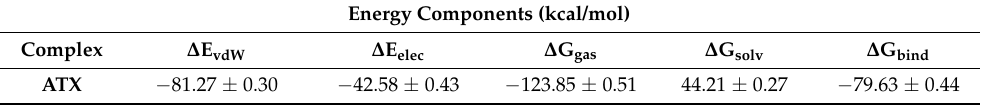
Table 1. Calculated energy binding for the ATX compounds against P450 CYP2C9 protein